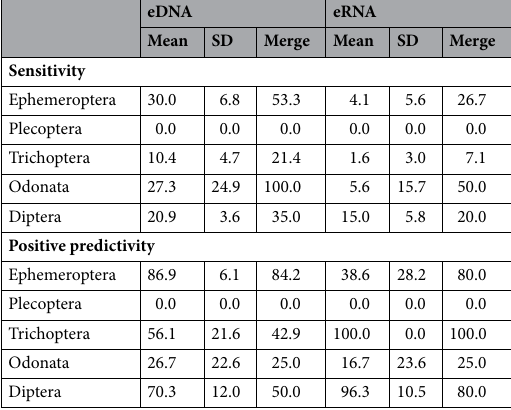
Table 2. Sensitivity and positive predictivity of metabarcoding analysis in each class.